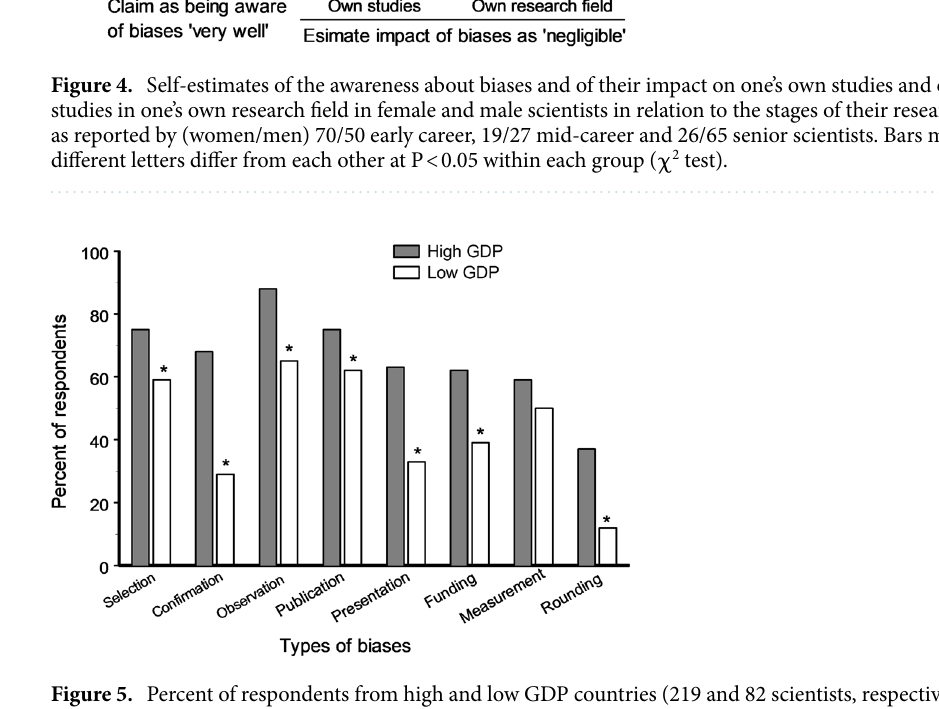
Figure 5. Percent of respondents from high and low GDP countries (219 and 82 scientists, respectively) who were aware of the most commonly known biases. Asterisks indicate significant (P < 0.05) differences between high and low GDP countries ( χ 2